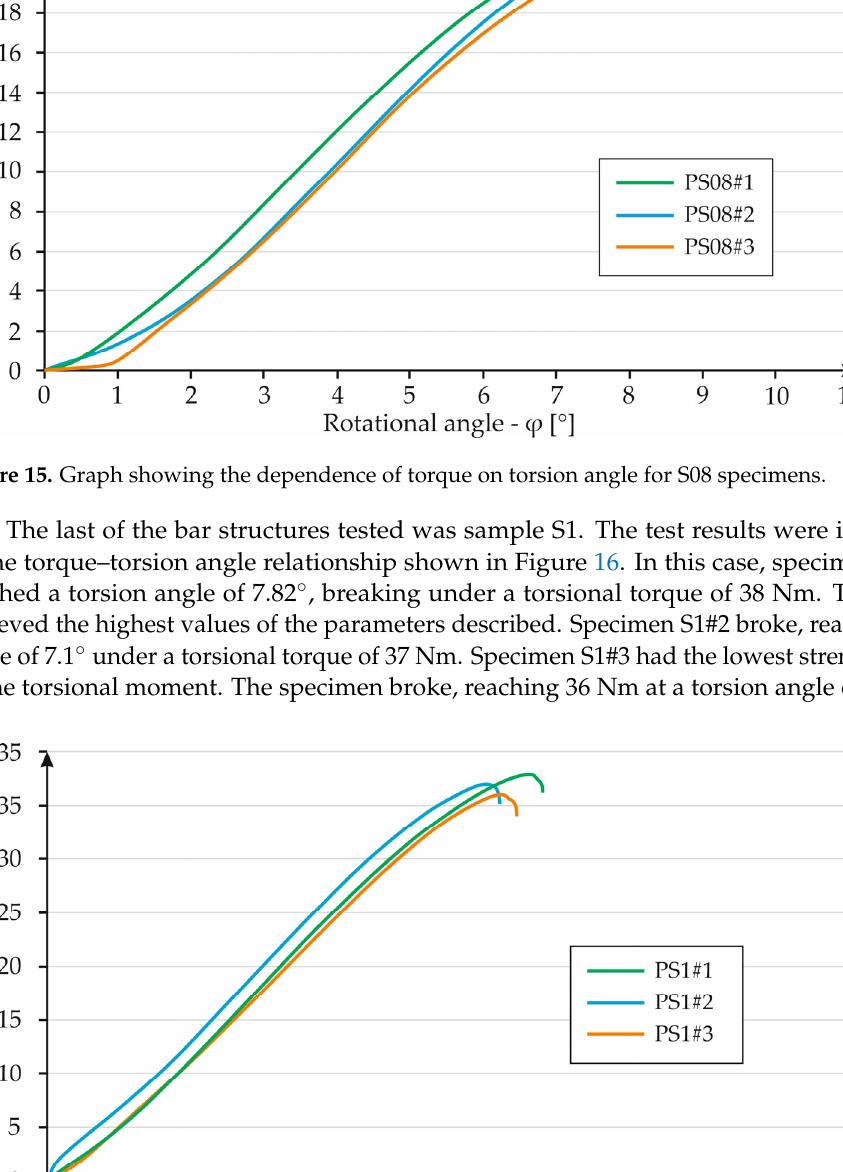
11 of 17 Figure 14. Graph showing the dependence of torque on torsion angle for PS06 specimens. Sample S08#1 reached an angle of 7.3° at a torsional torque of 21 Nm. Specimen S08#2